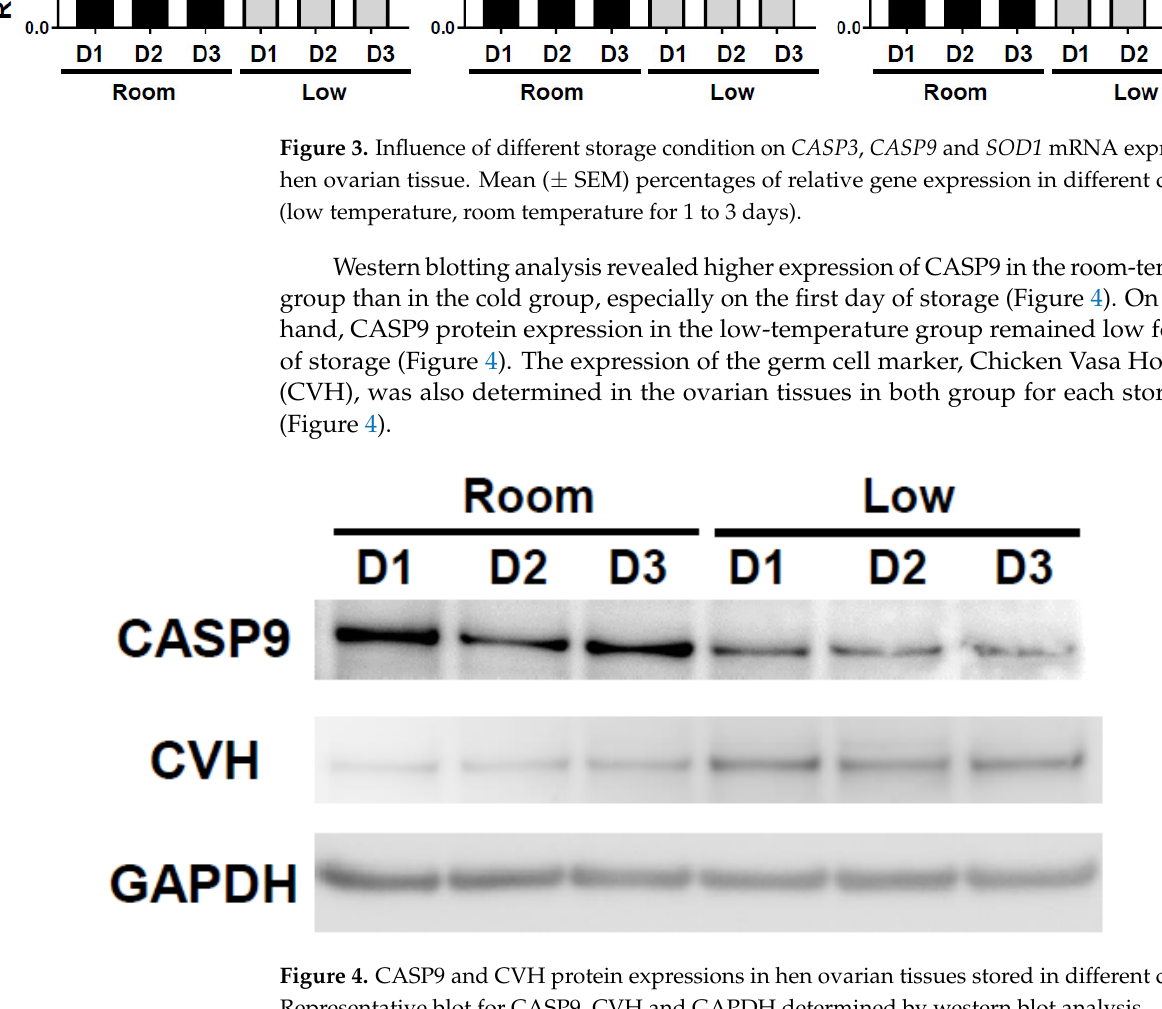
Figure 4. CASP9 and CVH protein expressions in hen ovarian tissues stored in different conditions. Representative blot for CASP9, CVH and GAPDH determined by western blot analysis.